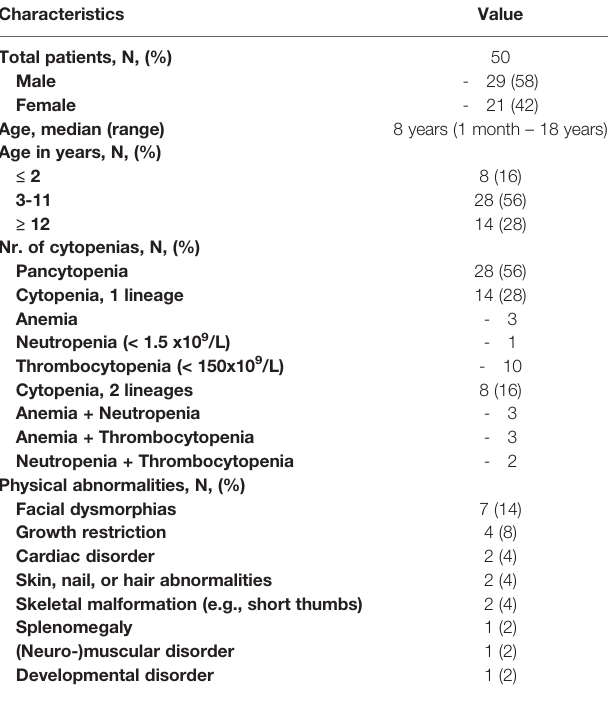
TABLE 1 | Patient